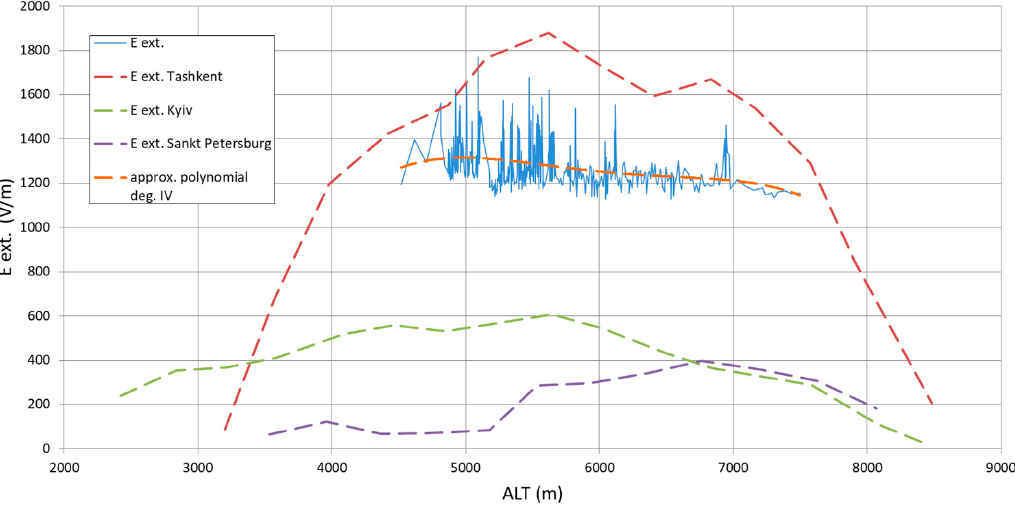
Figure 13. The comparison between electric field strengths in storm clouds from different locations.